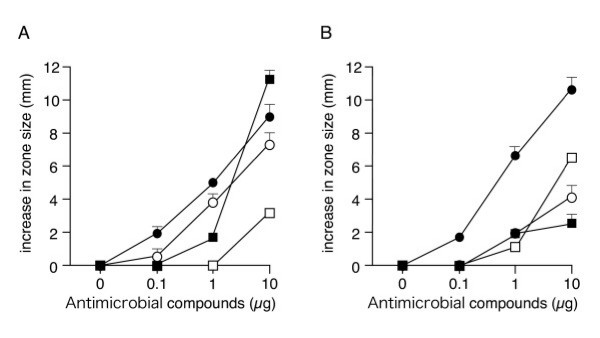
Antimicrobial activities of hBD-2 (open circles), hBD-3 (closed circles), hBD-4 (open squares), and penicillin G (closed squares). (A) E. coli HB101, (B) P. aeruginosa PAO1. An increase in zone size represents the zone size measured at each antimicrobial compound concentration minus the zone size of the central control well (3 mm). Data represent the means ± SD of three independent experiments.